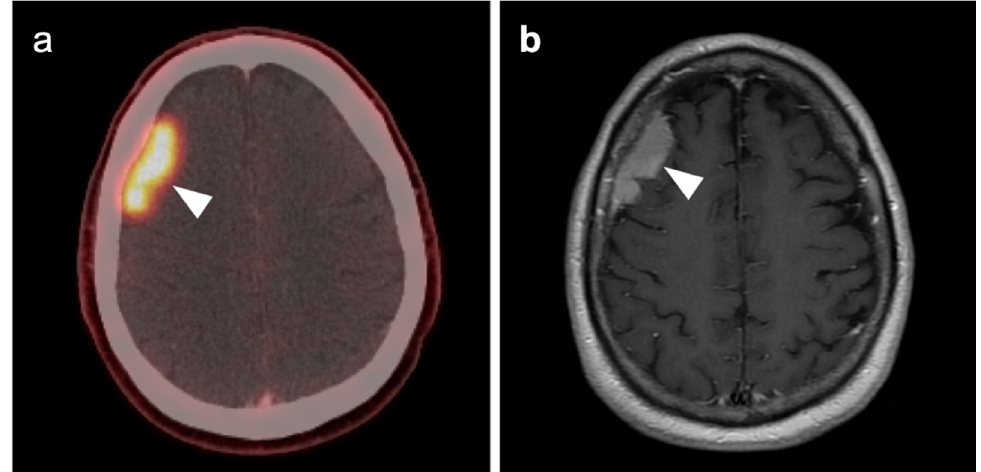
Figure 52. Meningioma on 18 F fluciclovine (Axumin ® ) PET ‐ CT. ( a ) An Axumin ® PET ‐ CT performed for evaluation of biochemically recurrent prostate cancer, incidentally noted to have an intensely PET ‐ positive right frontal dural ‐ based mass (white arrowhead). ( b ) This mass showed homogenous enhancement on Gd+ T1 MRI, arising from the dura, typical in appearance for a meningioma (white arrowhead).